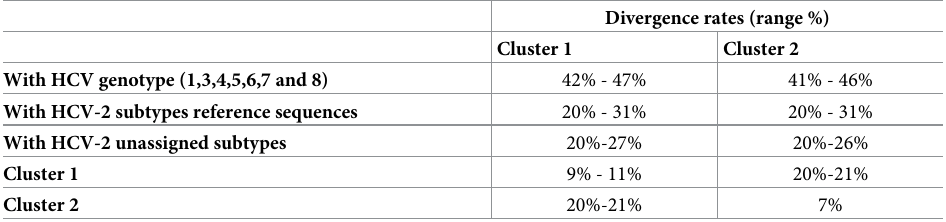
Table 1. Nucleotide divergence rates of Cluster 1 and Cluster 2 with HCV genotype and subtype